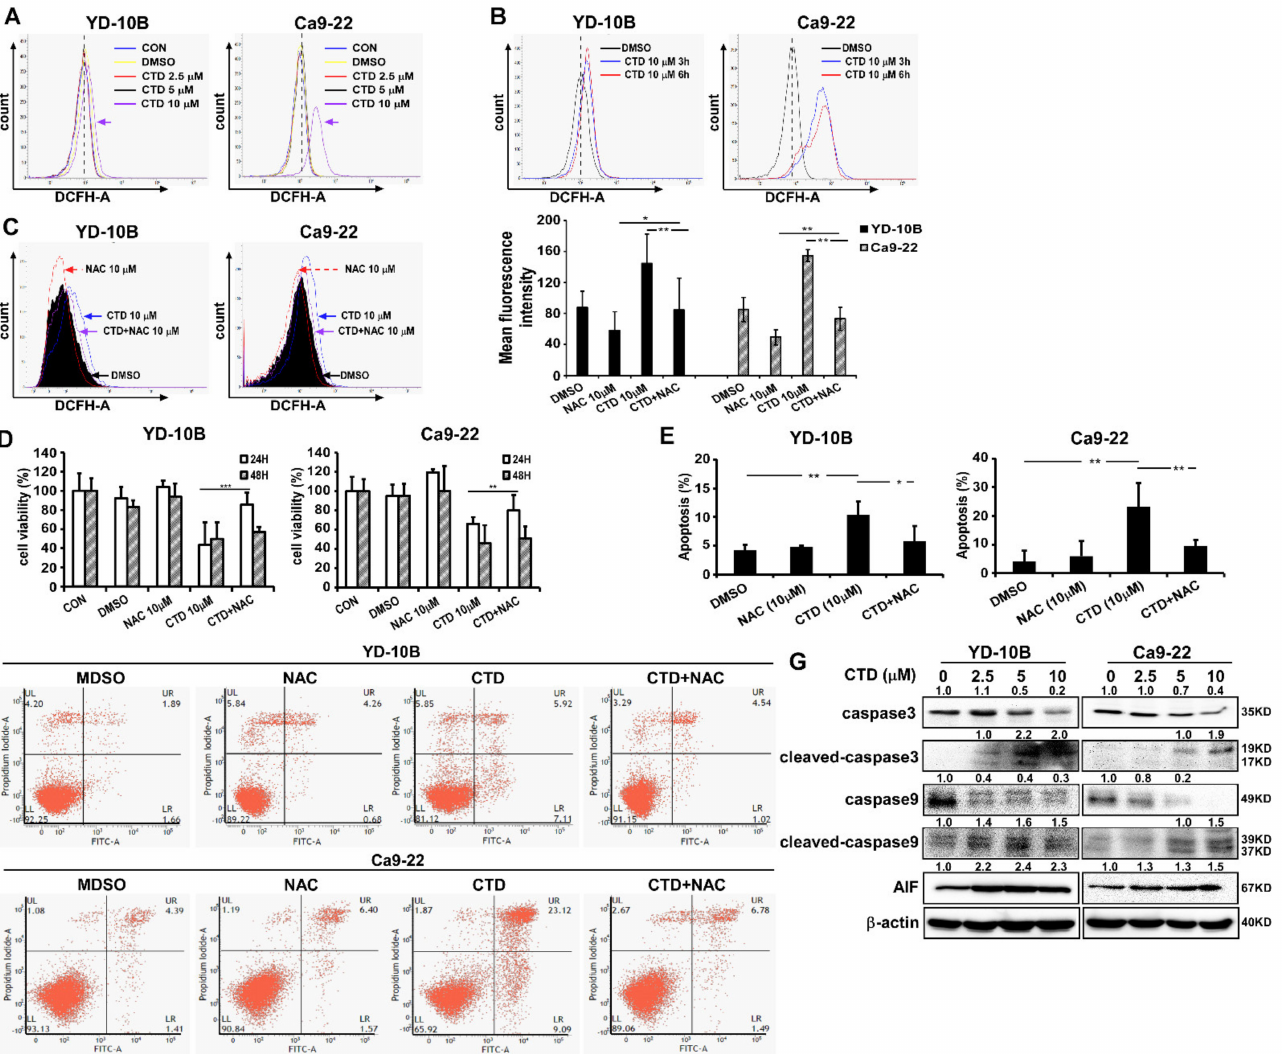
Figure 7. Induction of ROS generation by costunolide was examined in human oral cancer cells. ( A ) Flow cytometric analysis of ROS generation after the CTD treatment at different doses. ( B ) Analysis of ROS production after treatment with 10 µ M CTD at different time points. ( C ) Cells were treated with 10 µ M CTD and 10 mM NAC each alone or in combination for 24 h. DCFH-A staining was used to evaluate ROS production (left). The mean fluorescence intensity of DCFH-DA staining is shown in oral cancer cells (right). ( D ) Cell proliferation was detected by the MTT assay in oral cancer cells treated with 10 µ M CTD and 10 mM NAC each alone or in combination at different time points. ( E ) Cells treated with 10 µ M CTD and 10 mM NAC each alone or in combination for 24 h; cell apoptosis was examined by the flow cytometry assay. ( F ) Image of apoptotic cell populations. ( G ) ROS production was induced after the CTD treatment leading to some protein expression. Values are expressed as mean ± SD ( n = 3); * p < 0.05, ** p < 0.01 and *** p < 0.001 indicate a significant difference compared with